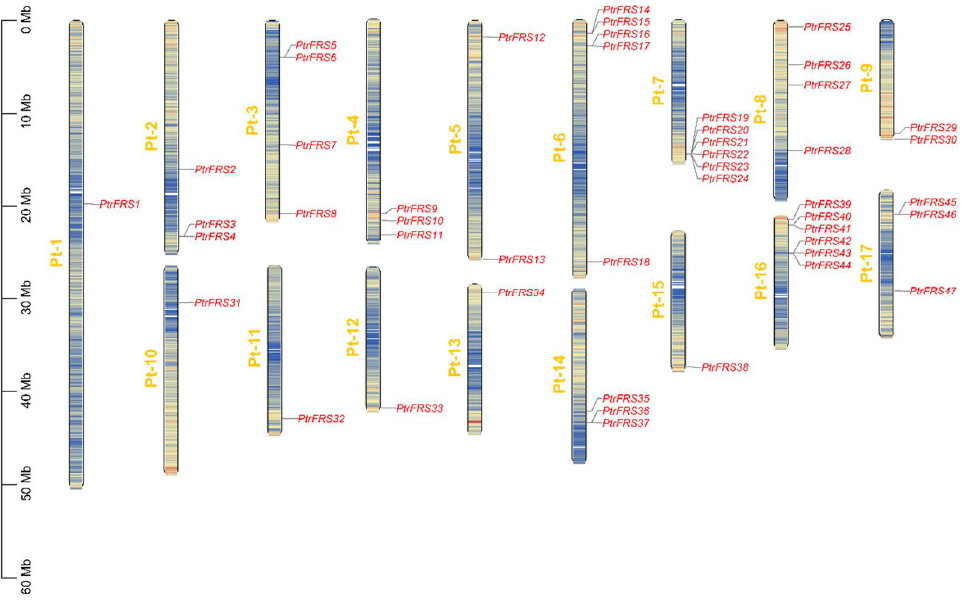
Figure 1. Chromosome localization of the PtrFRS s.